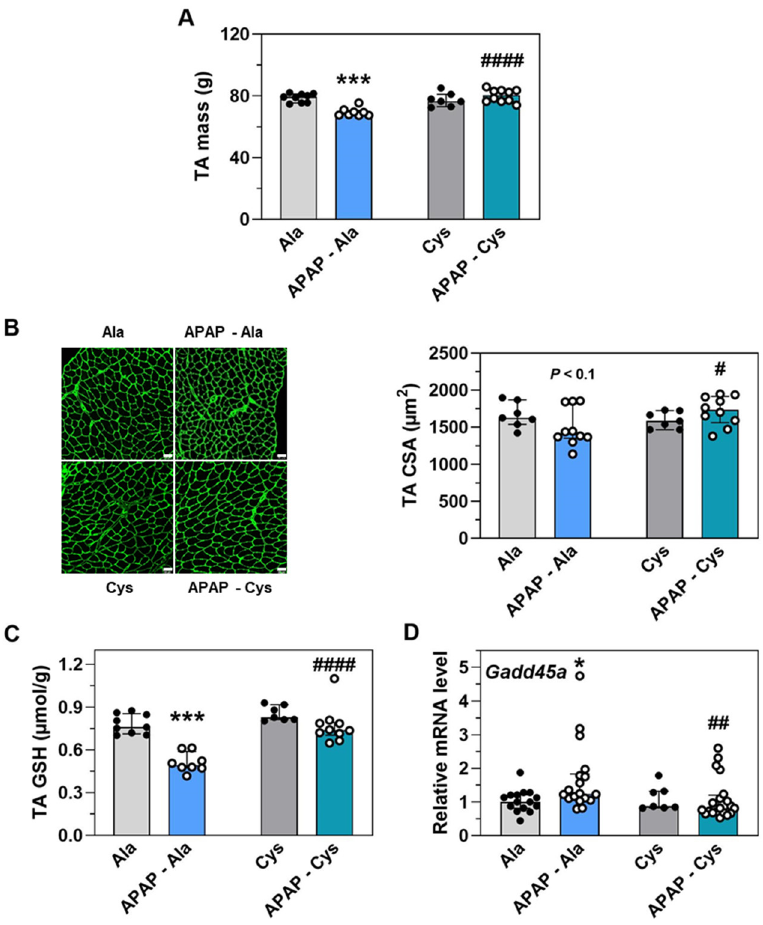
Figure 8. Effect of dietary supplementation with Cys on the response of tibialis anterior (TA) muscle to treatment with APAP for 18 d. Ctrl and APAP diets were supplemented with alanine (Ala) or cysteine (Cys). Ala was added to make diets iso-nitrogenous to Cys diets. The APAP-Cys group was fed ad libitum. The three other groups were pair-fed with the APAP-Cys group. ( A ) Mass of the two TA muscles. ( B ) Cross-sectional area (CSA) of muscle fibers. Scale bar = 50 µm. ( C ) Total GSH concentration in the TA. ( D ) Expression of the ATF4-dependent gene Gadd45 . Total RNA extracted from the liver was analyzed by reverse transcription RT-qPCR. Each bar shows the median with interquartile and dots are individual values. * p ≤ 0.05; *** p ≤ 0.001 vs. PF-Ala; # p ≤ 0.05; ## p ≤ 0.01; #### p ≤ 0.0001 vs. respective Ala group; Mann Whitney test.